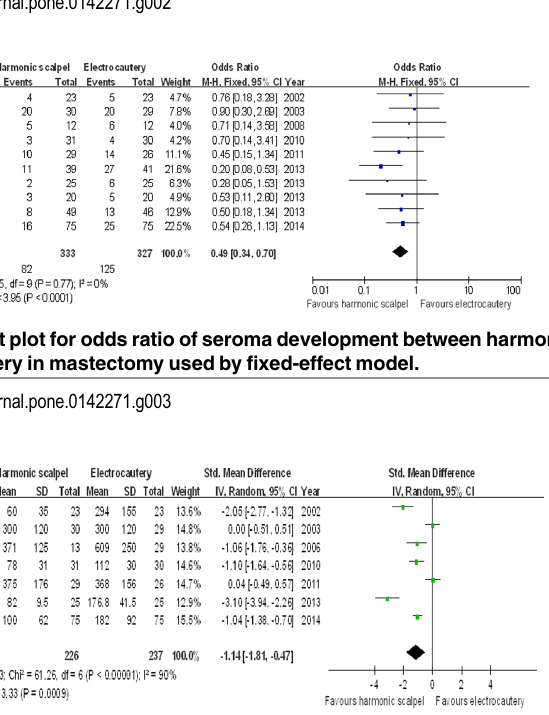
Fig 4. Forest plot for weighted mean difference in intraoperative blood loss between harmonic scalpel dissection and electrocautery in mastectomy used by random-effect model.